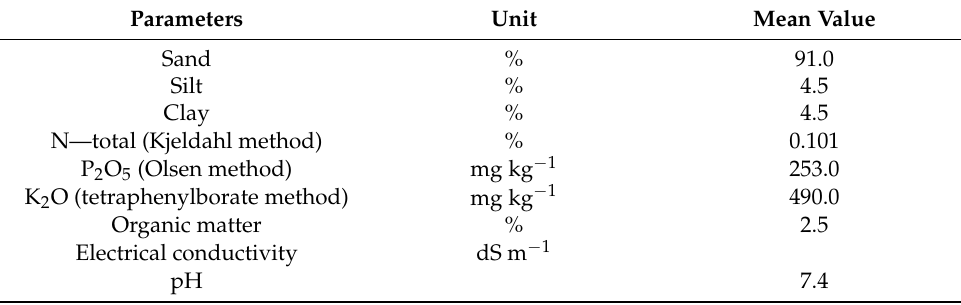
Table 1. Physical and chemical properties of the test soil. Parameters